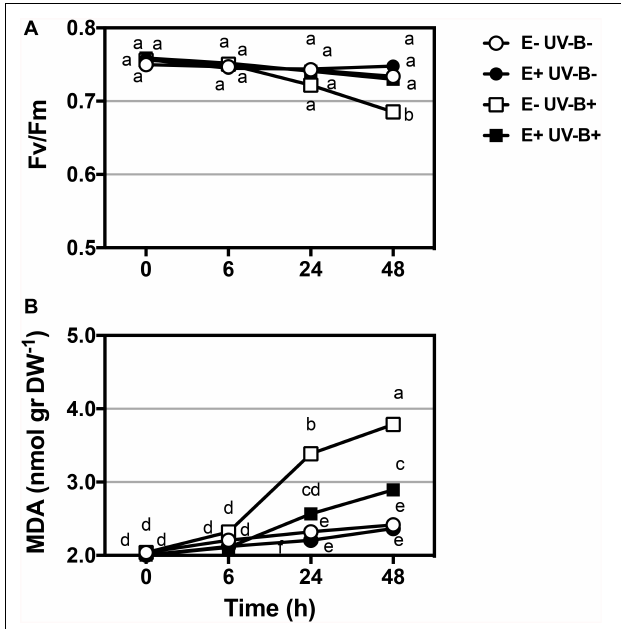
FIGURE 1 | Physiological performance (lipid peroxidation and PSII photochemical efficiency - Fv/Fm) in Colobanthus quitensis exposed to UV-B radiation with and without endophytes. PSII photochemical efficiency (Fv/Fm) (A) and Malondialdehyde MDA (B) variation in the leaves of Colobanthus quitensis were evaluated under UV-B radiation. Control (without radiation UV-B radiation) and UV-B (46 µ mol m − 2 s − 1 ) radiation in plants with and without endophytes (E+ and E-) were analyzed. Different letters indicate significant differences ( P < 0.05; two-way ANOVA). Bars represent means ± SE from three independent